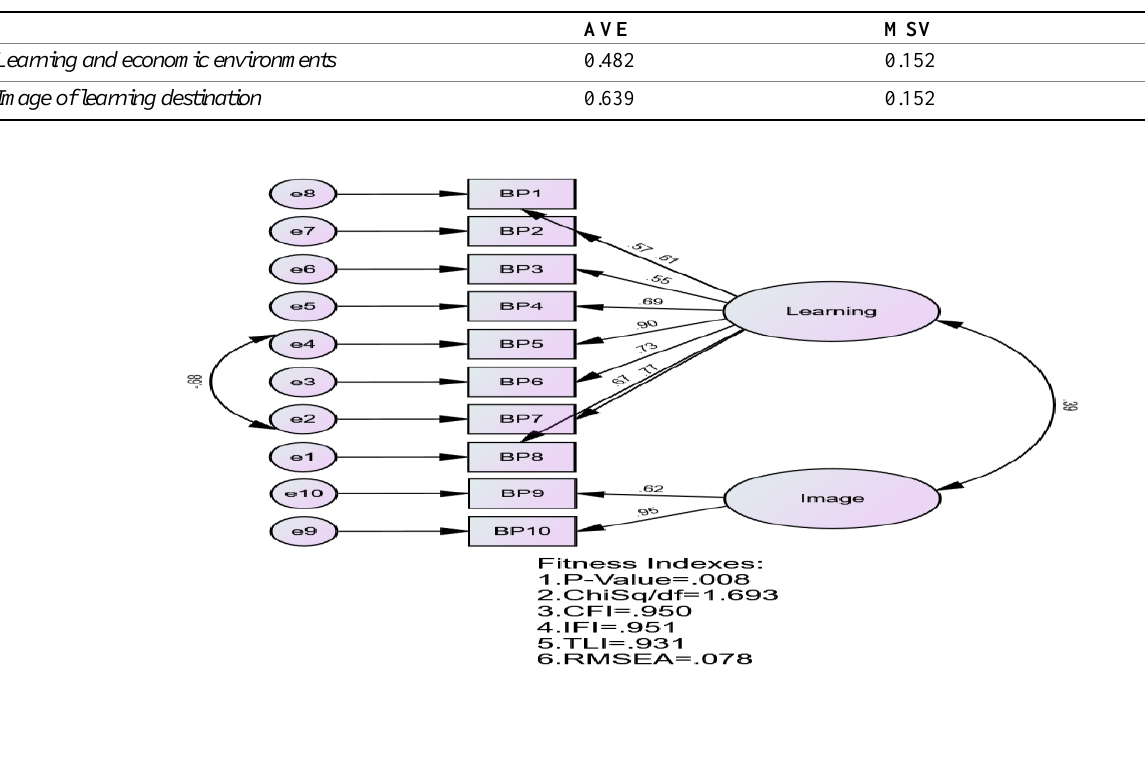
Table 7: Convergent and discriminant validity for factors influencing students’ information needs